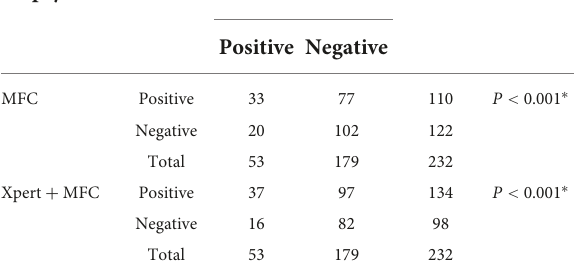
TABLE 3 Infectious diagnosis of core needle biopsy and aspiration biopsy ( n = 232).